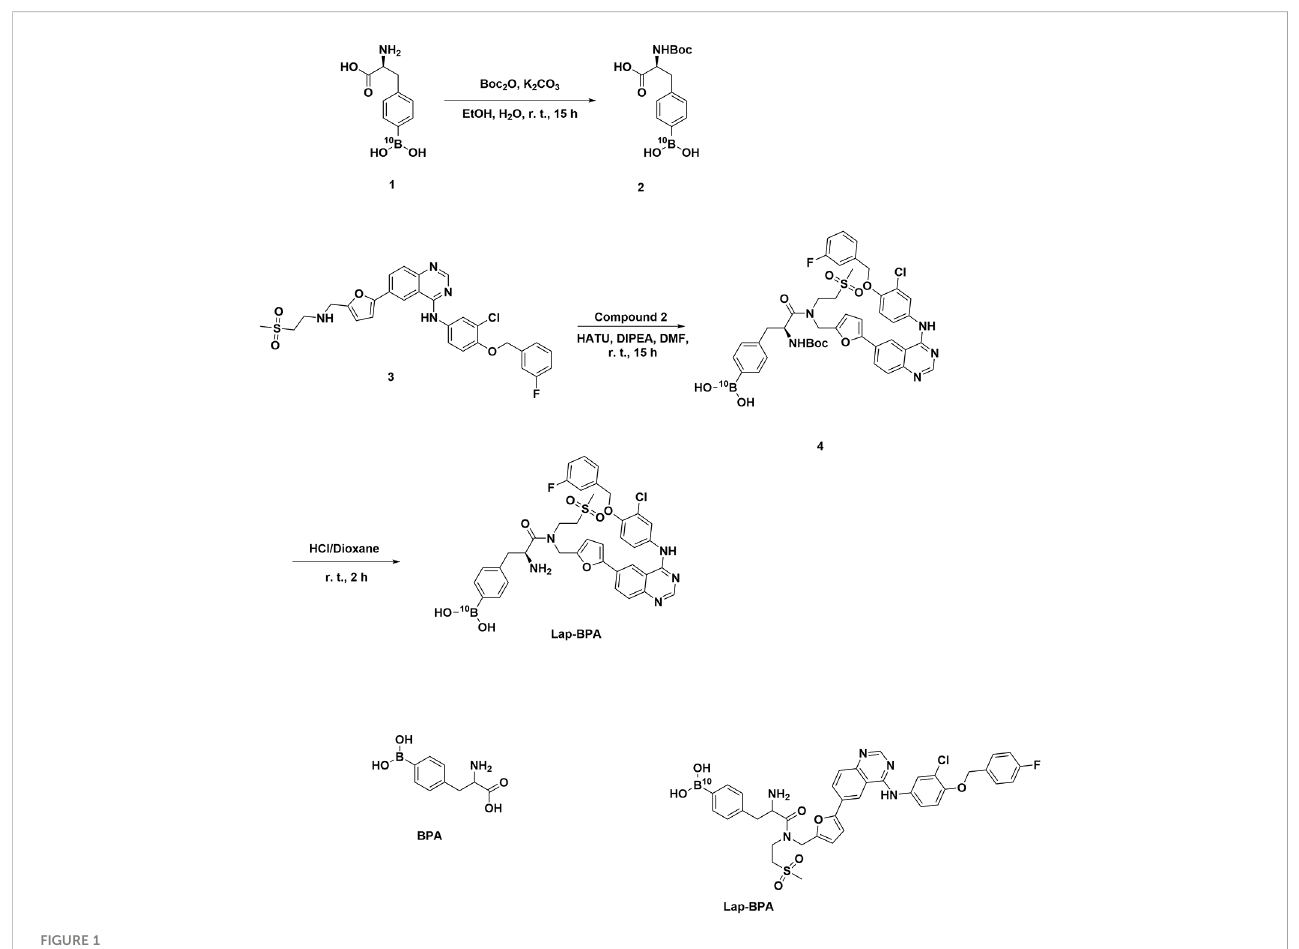
FIGURE 1 Synthesis of